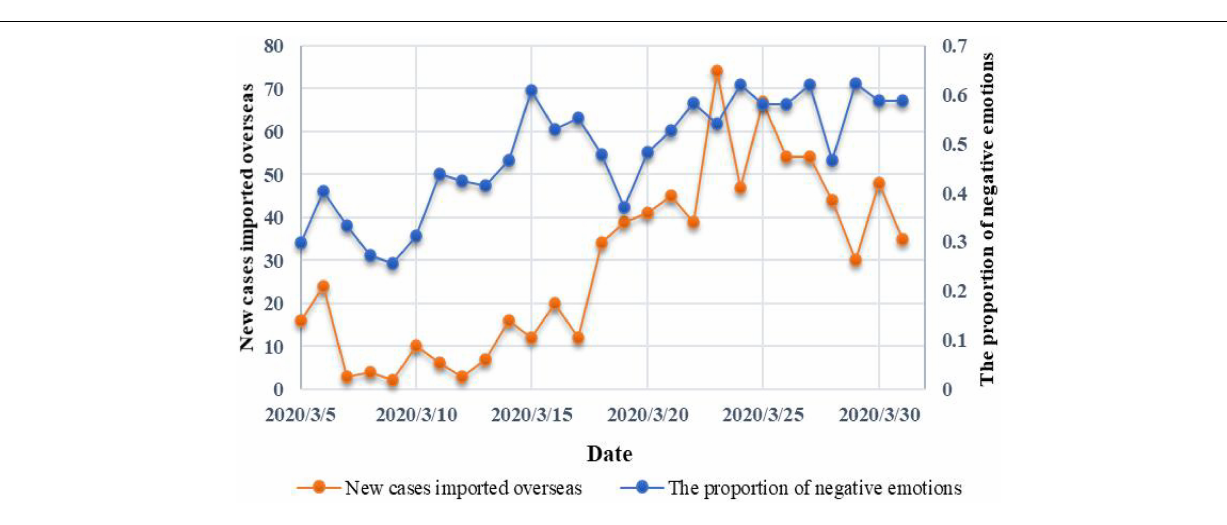
FIGURE 6 | Changes in the proportion of people’s negative emotions and the number of newly imported cases abroad.